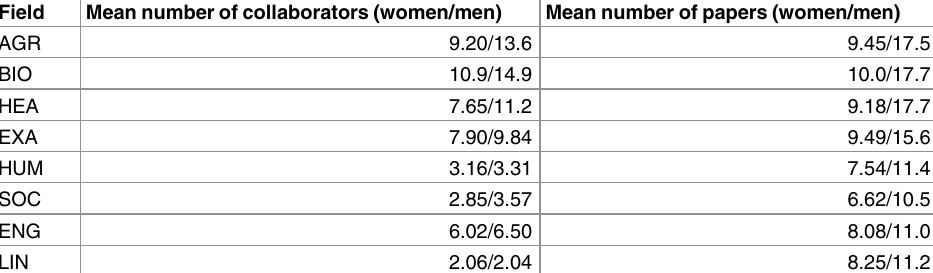
Table 2. Mean number of collaborators and published papers for men and women for each of the eight major fields: Agricultural Sciences (AGR), Applied Social Sciences (SOC), Biological Sciences (BIO), Exact and Earth Sciences (EXA), Humanities (HUM), Health Sciences (HEA), Engineering (ENG) and Linguistics and Arts (LIN).